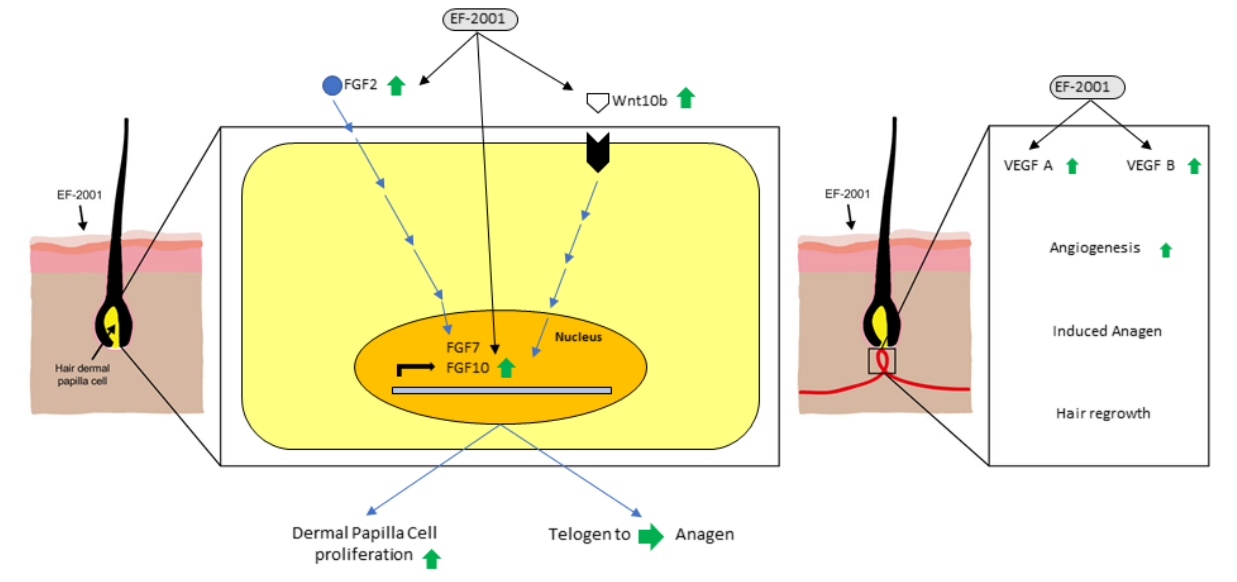
Figure 8. EF-2001 affects hair regrowth in vitro and in vivo